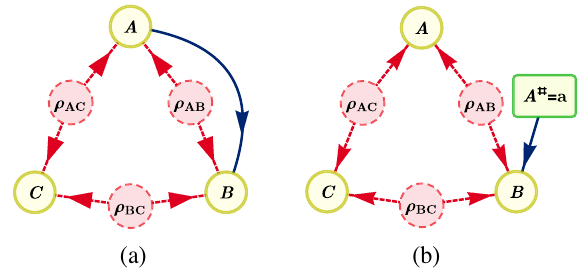
FIG. 18. (a) The triangle scenario supplemented with a directed edge from A → B . (b) The relevant interrupted graph used to both define and compute the ACE of A on B